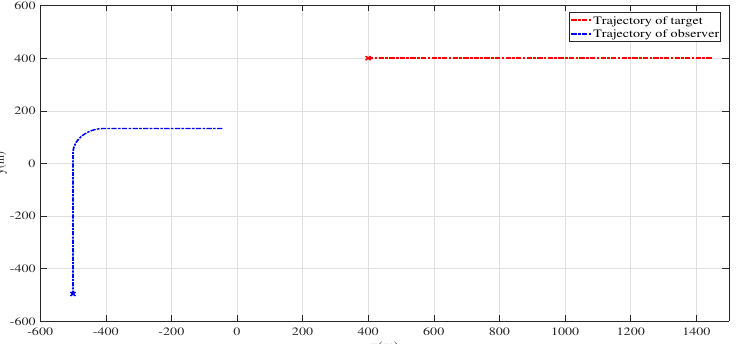
Figure 2. Geometry for scenario 1. The red curve represents the target trajectory while the observer trajectory is given by the blue curve.